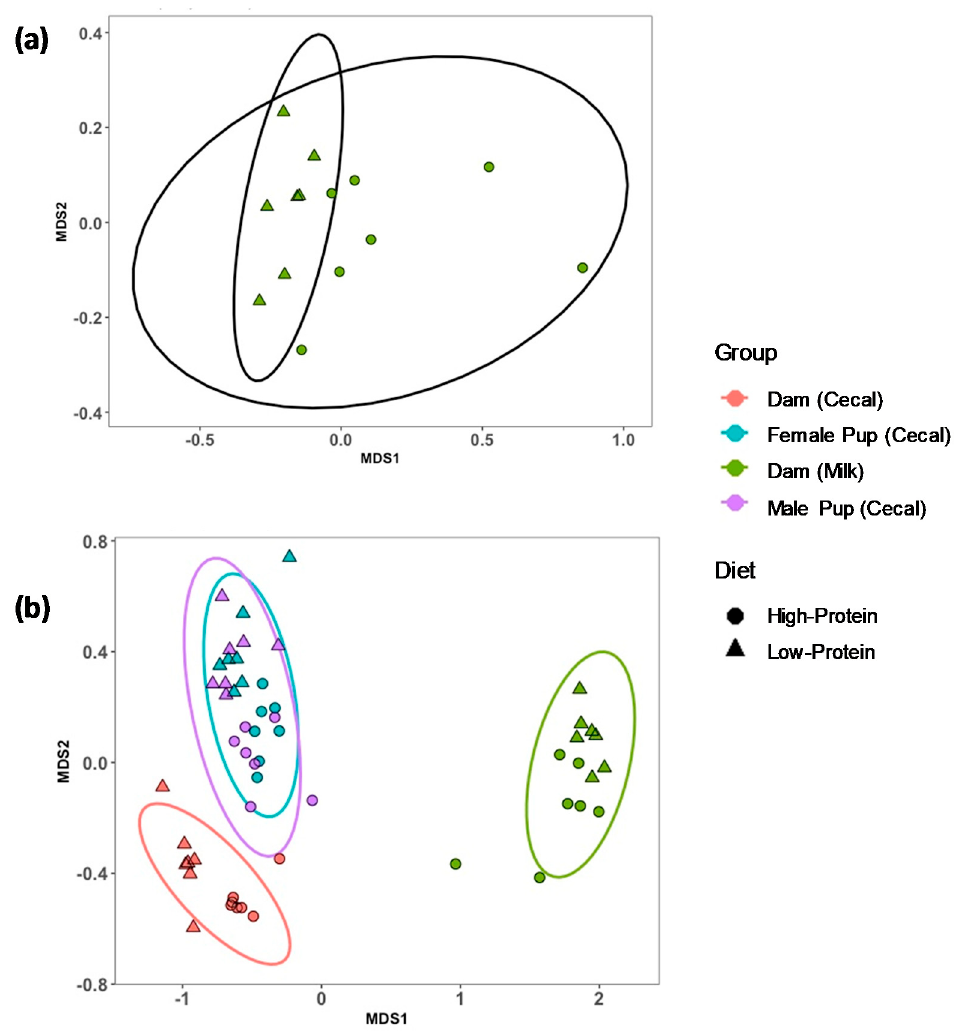
Figure 2. Non-metric multidimensional scaling (nMDS) plots of ( a ) rat dam milk samples grouped by diet and ( b ) rat dam cecum, pup cecum, and dam milk. Ten percent protein (LP) diet samples denoted by triangles and 20% protein (HP) diet samples denoted by circles. Bacterial OTUs were clustered using Bray–Curtis. Stress was ( a ) 0.12 and ( b ) 0.07.